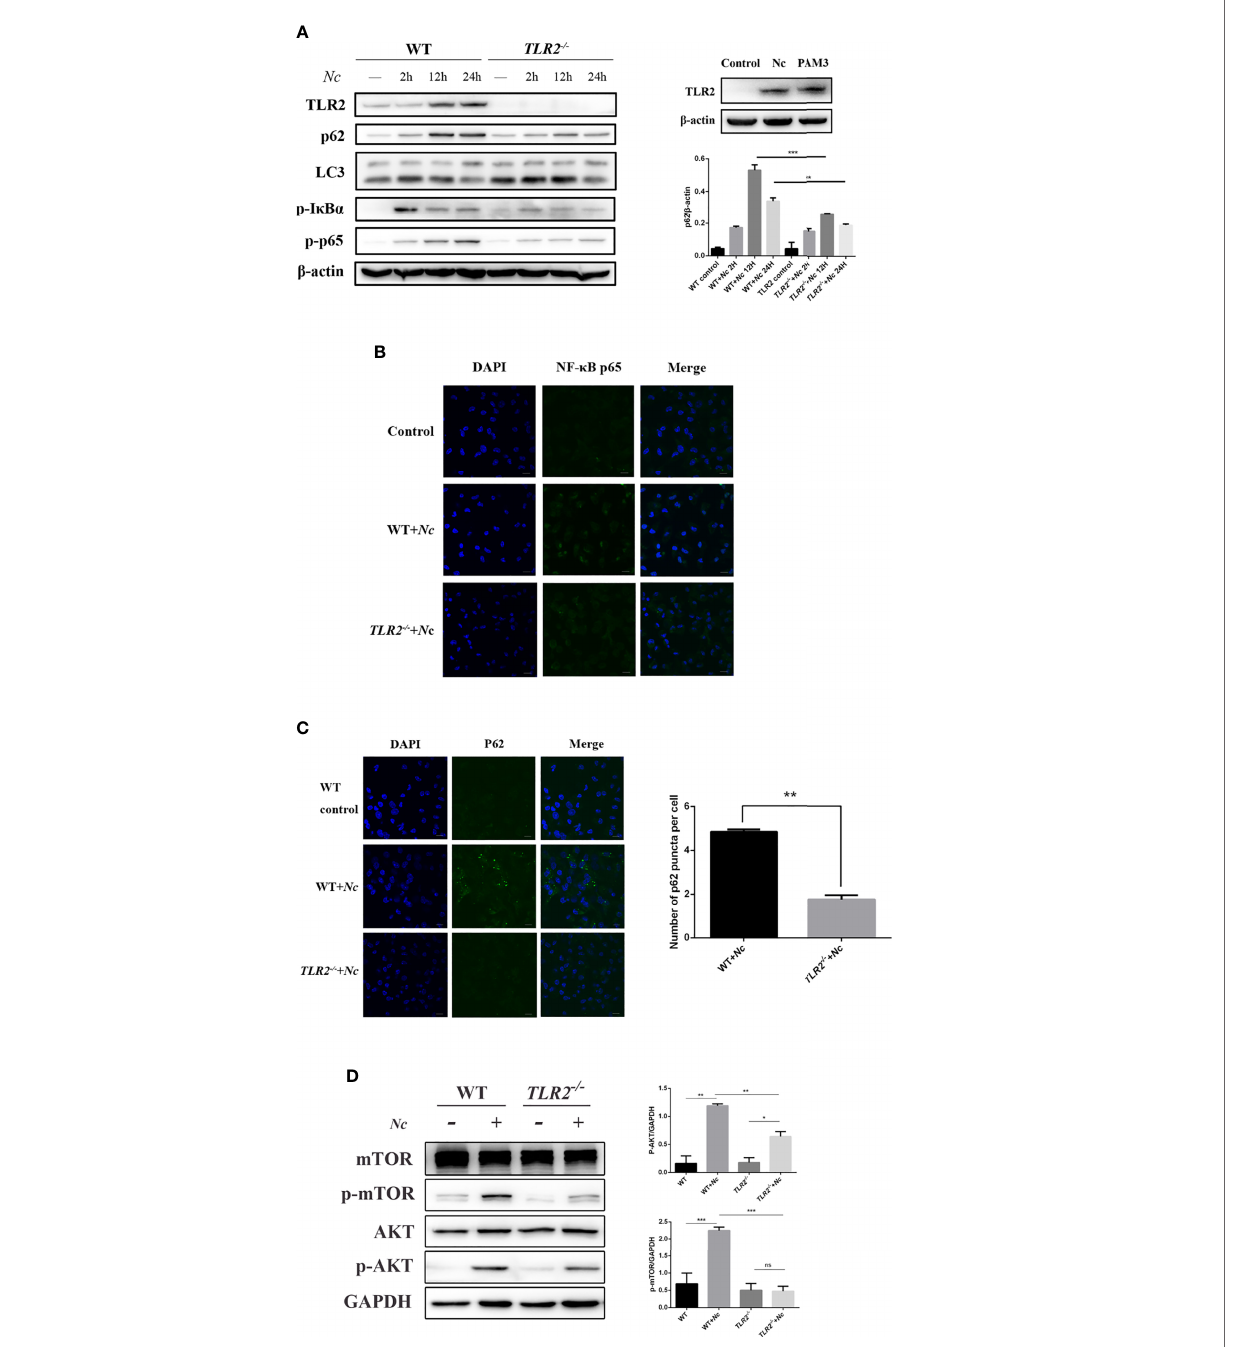
FIGURE 4 | Activation of the TLR2 – NF- k B and mTOR signaling pathways by N. caninum infection impairs autophagy in mouse peritoneal macrophages (PMs). (A) Western blot analysis of TLR2, p62, LC3, p-I k B a , p-p65, and b -actin in macrophages from WT and TLR2 − / − mice infected with N. caninum (MOI = 3) for 2, 12, and 24 h. Macrophages were treated with Pam3CSK4 (10 m g/ml) as a positive control. The rate of p62/ b -actin was shown. (B) Confocal microscopy was used to detect the translocation of NF- k B from the cytoplasm to the nucleus in both WT and TLR2 − / − mouse peritoneal macrophages. Scale bars: 10 m m. (C) Eight hours postinfection with N. caninum (MOI = 3), the accumulation of p62/SQSTM1 was examined by confocal microscopy in both the WT and TLR2 − / − groups. Quantitative analysis of the number of p62 puncta. The graph represents the average data of at least 100 cells in each experimental group in three independent experiments. Scale bars: 10 m m. (D) WT and TLR2 − / − mouse PMs were infected with N. caninum (MOI = 3) for 8 h and then immunoblotted for whole-cell lysis analysis of p-mTOR and p-AKT protein expression. The phosphorylated mTOR and AKT amounts were quanti fi ed by densitometric analysis. The data are expressed as the mean ± SEM from three separate experiments. * P < 0.05; ** P < 0.01; *** P < 0.001; ns indicates not signi fi